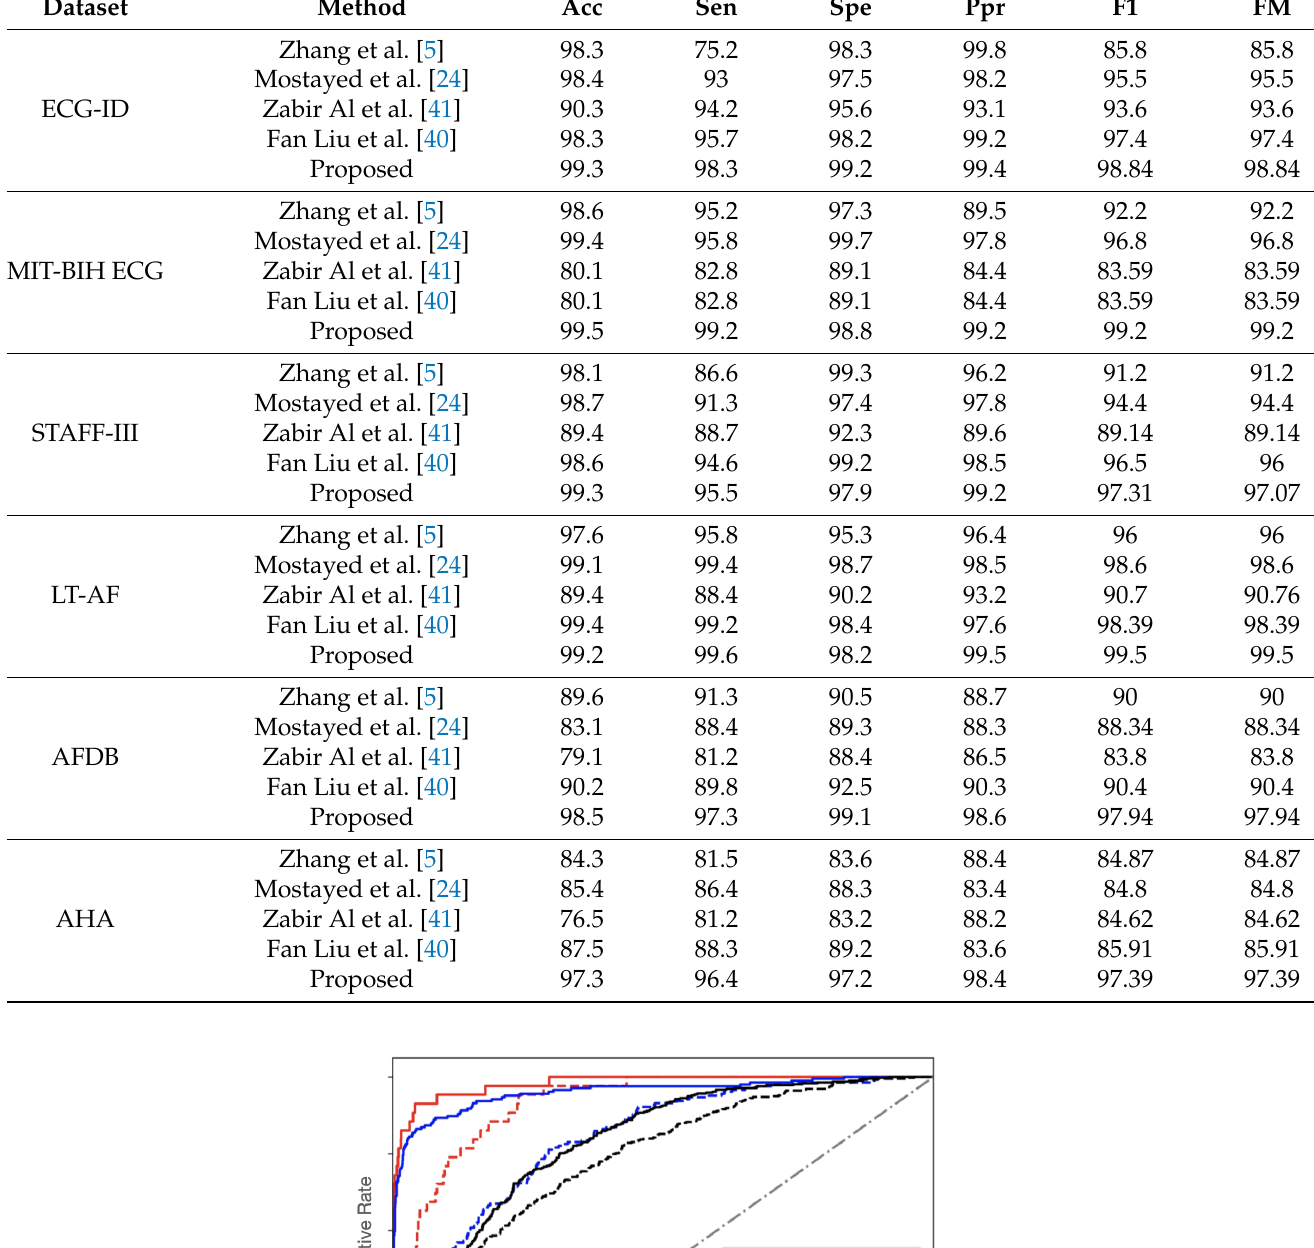
Table 4. Comparison of the proposed method with recent state-of-the-art works in terms of classification accuracy of 20 classes over four different datasets (ECG-ID, MIT-BIH, STAFF-III, LT-AF, AFDB, and AHA).